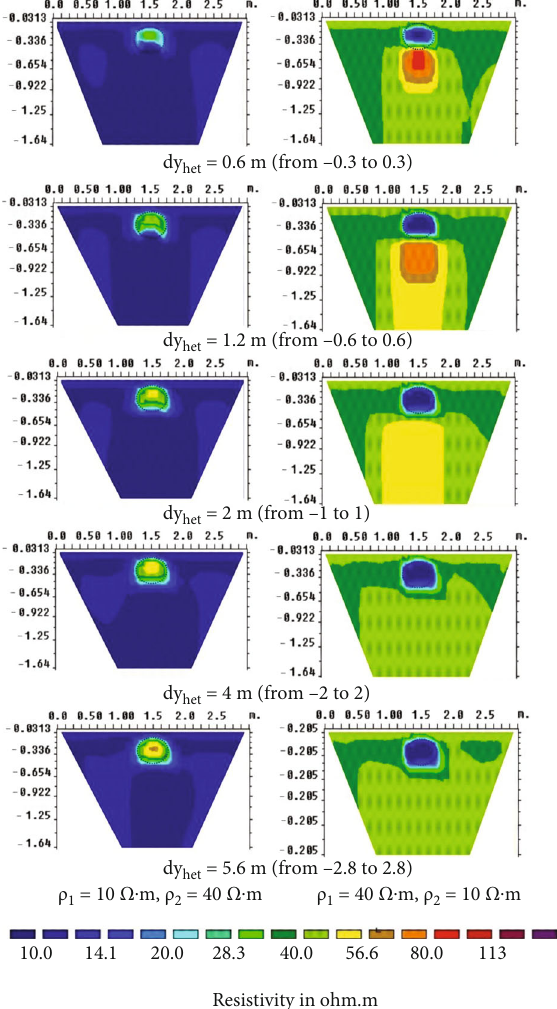
Figure 8: The in fl uence of the inhomogeneity ’ s size of a 3D medium with a fl at ground surface in the Y-direction on the results of 2D